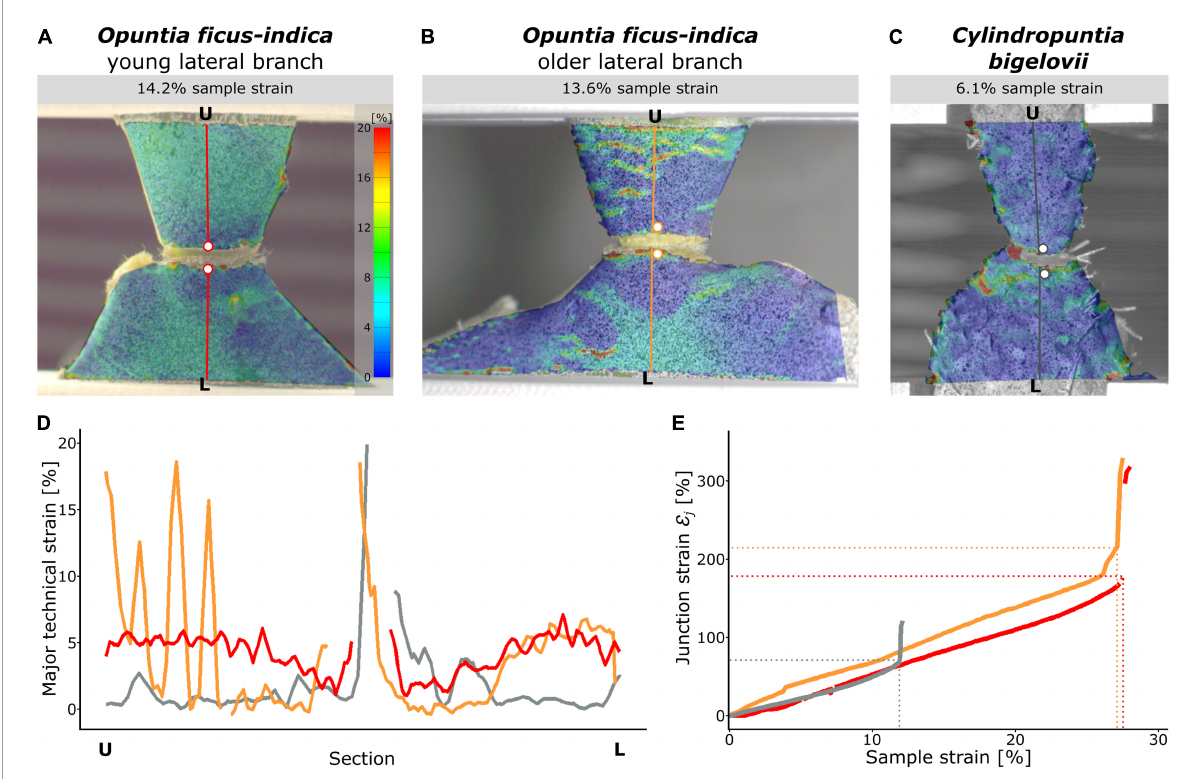
FIGURE8 Local strain analysis during tensile loading of the junction samples using the digital image correlation technique. The surface strains (major strain) of selected samples of (A) Opuntia ficus-indica with a young lateral branch, (B) O. ficus-indica with an older lateral branch, and (C) Cylindropuntia bigelovii at the stage of about the respective half maximum sample strain are shown color-coded (scale in (A) applies to all the three sub-figures). Please note that large local strains resulted in loss of surface detection at the junctions. Constructed sections running orthogonally from the lower clamping (L) to the upper clamping (U) midway through the junctions are marked in color. The two points directly basal and apical to the junction (colored dots with a white filling) are used to calculate the junction strain. (D) Course of the local strains at the given sample strain along the sections (each normalized to the length from L to U). For better comparability, the Y -axis is limited to 20% strain; larger strain values occurred only directly at the junction and were calculated as junction strain ε j . (E) Junction strains over the duration of the tensile test represented as sample strain. The dashed horizontal and vertical lines mark the failure of the respective samples. In (D,E) , the red curves belong to a sample of O. ficus-indica with a young lateral branch, the orange curves to a sample of O. ficus-indica with an older lateral branch, and the gray curves to a sample of C. bigelovii